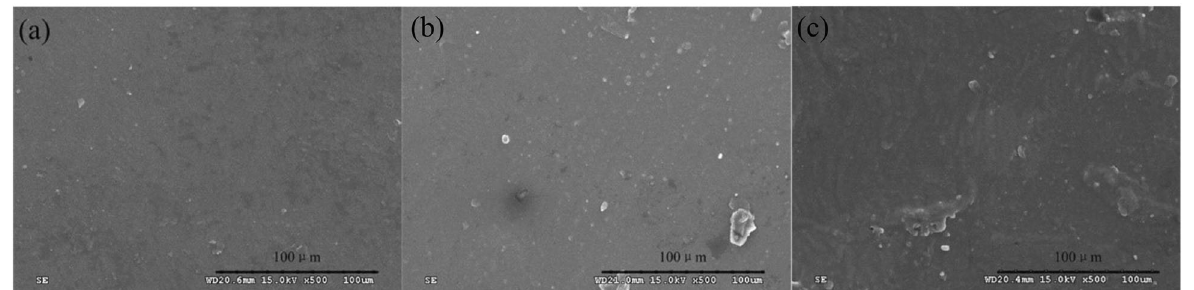
Fig. 8 The SEM of cartilage in different pairs. a PEEK/cartilage; b CoCrMo/cartilage; c